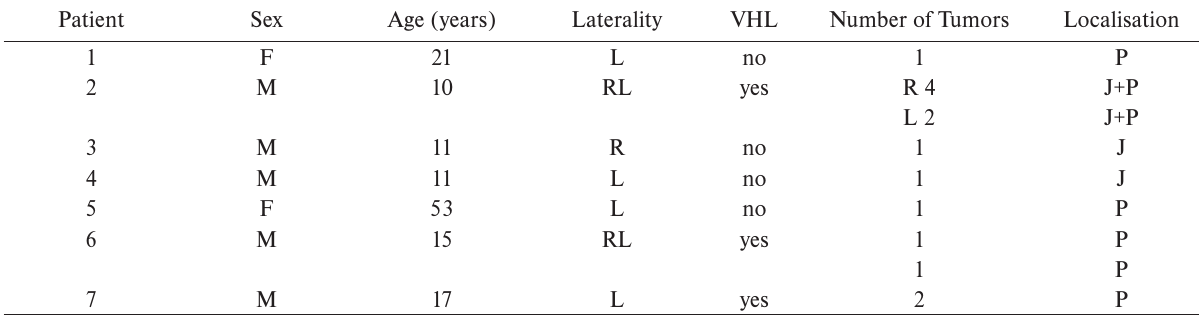
Table 1. Cohort of patients with retinal capillary hemangioma.